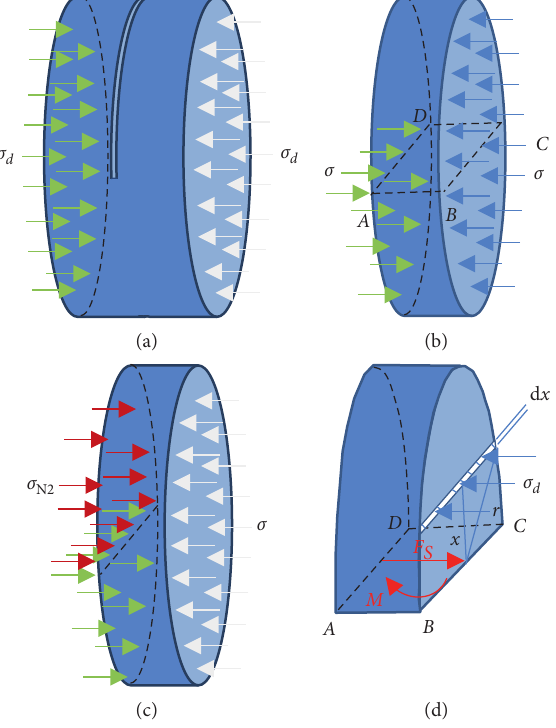
Figure 15: Force